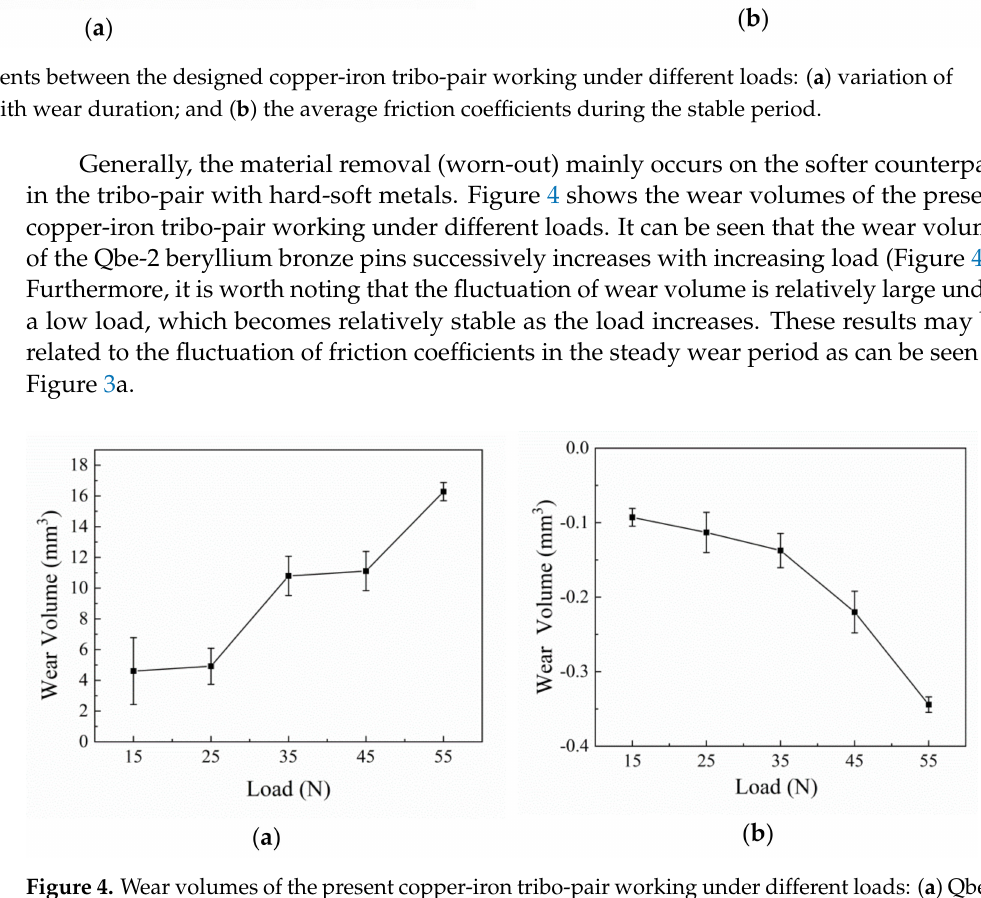
Figure 4. Wear volumes of the present copper-iron tribo-pair working under different loads: ( a ) Qbe-2 beryllium bronze pin; and ( b ) 38CrMoAl steel